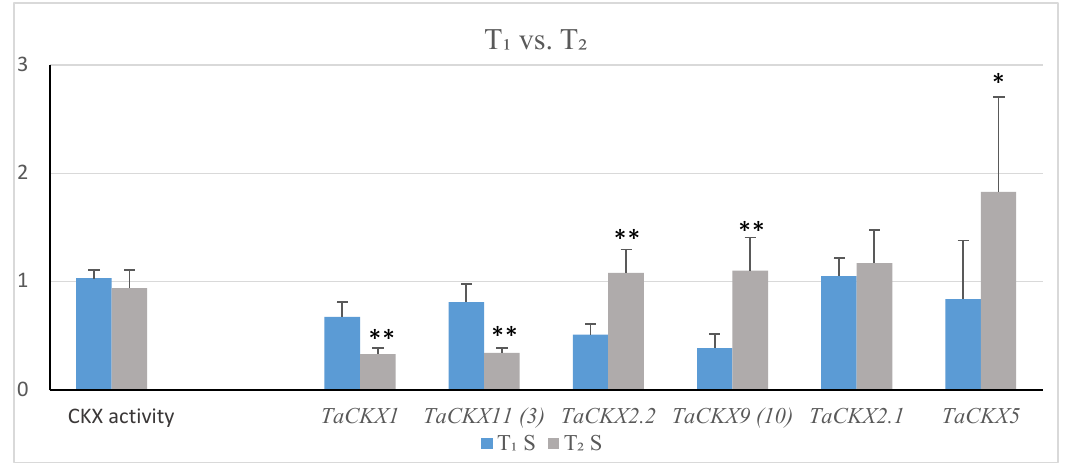
Figure 2. Comparison of means of relative CKX enzyme activity and selected gene expression levels in T 1 (bars) and T 2 (line) generation of silenced lines. *—significant at p < 0.05; **—significant at p < 0.01. Table 1. Effect of TaCKX1 silencing on expression levels of selected TaCKX genes presented by expression ratio indicator (mean value in silent/mean value in non-silent, control plants) in T 1 and T 2 generations.